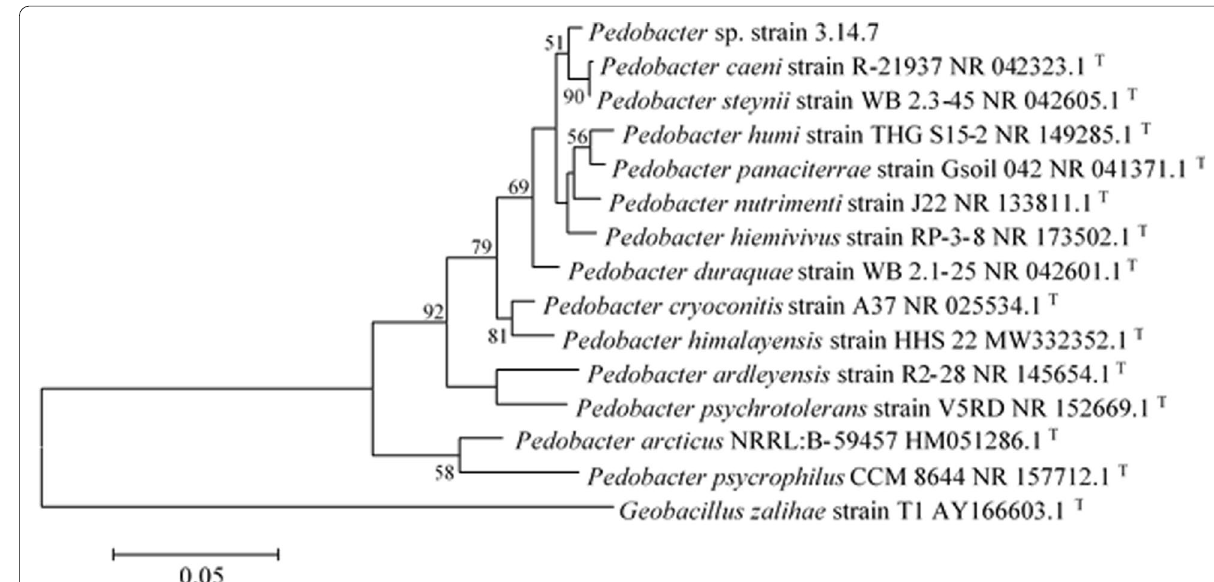
Fig. 1 Phylogenetic tree of Pedobacter sp. 3.14.7 (MF 347939.1) within the relative strains of genus Pedobacter . The tree was created using the